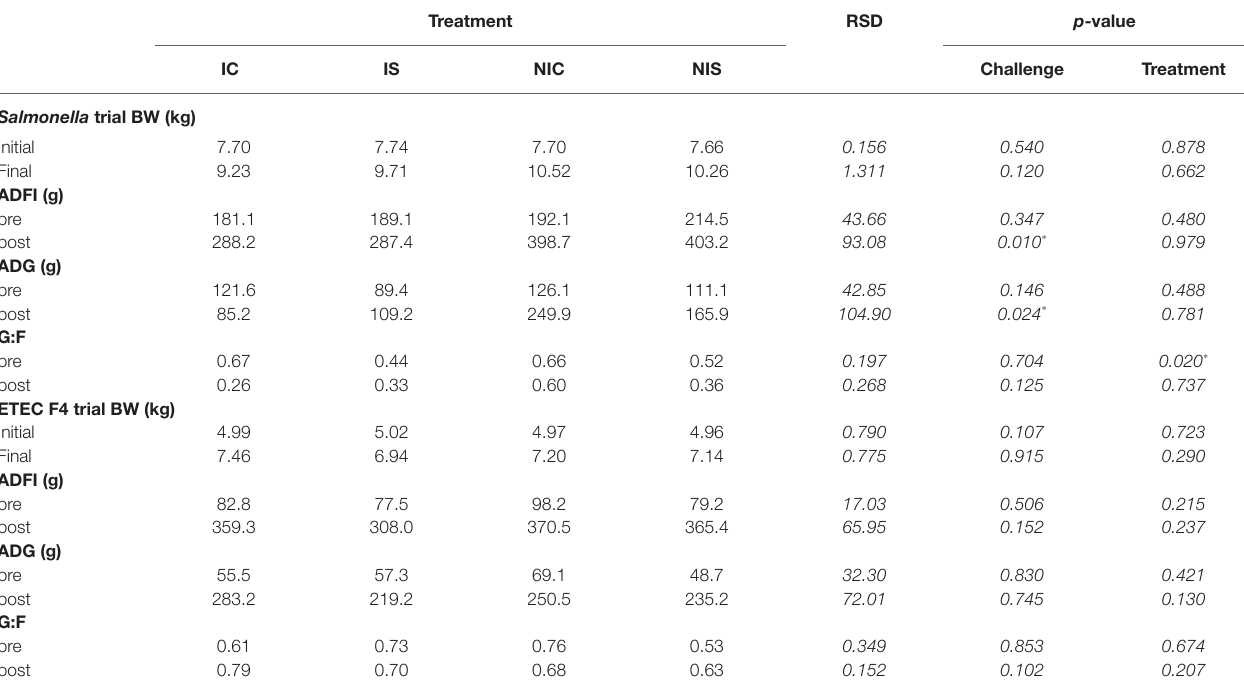
TABLE 2 | Effects of experimental treatments on feed intake and weight gain.